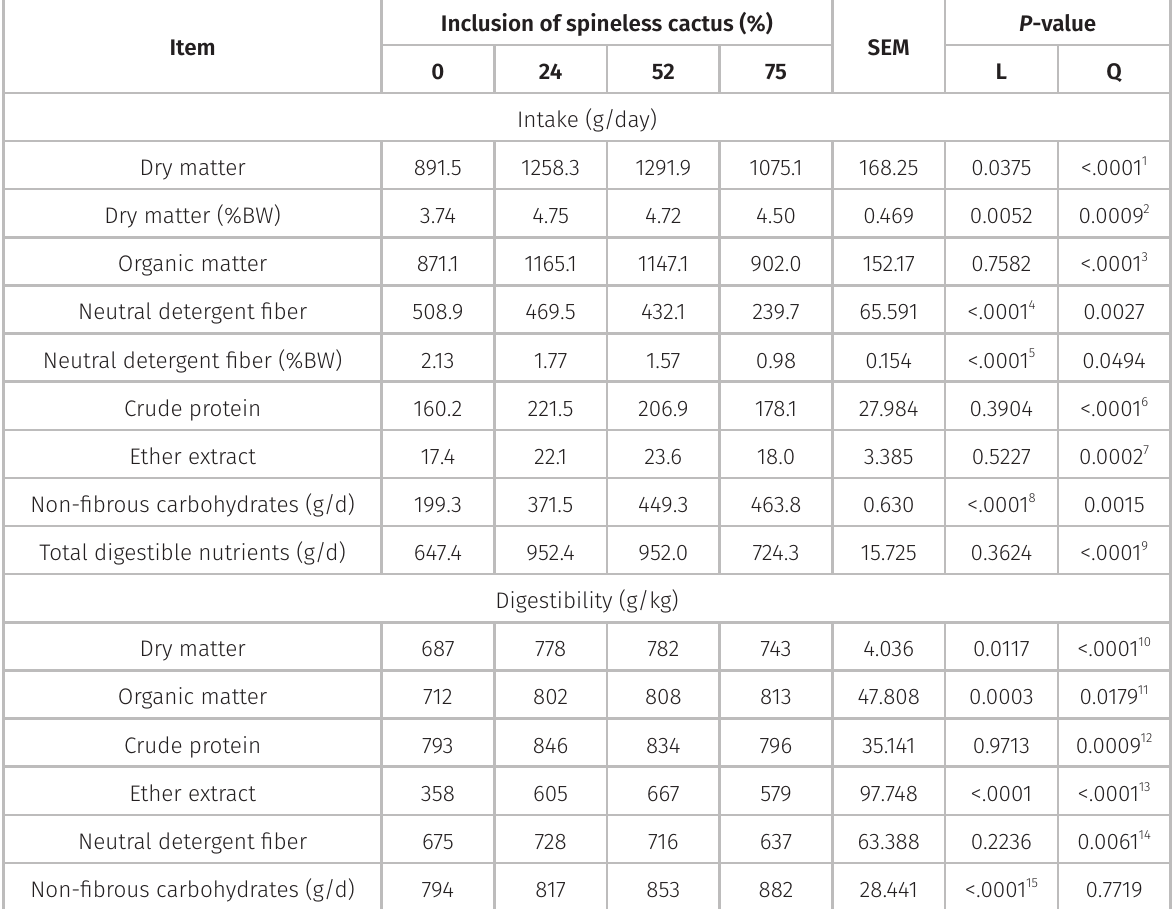
Table III. Nutrient intake and digestibility of lambs fed with increasing levels of spineless cactus inclusion in the diet. Body weight